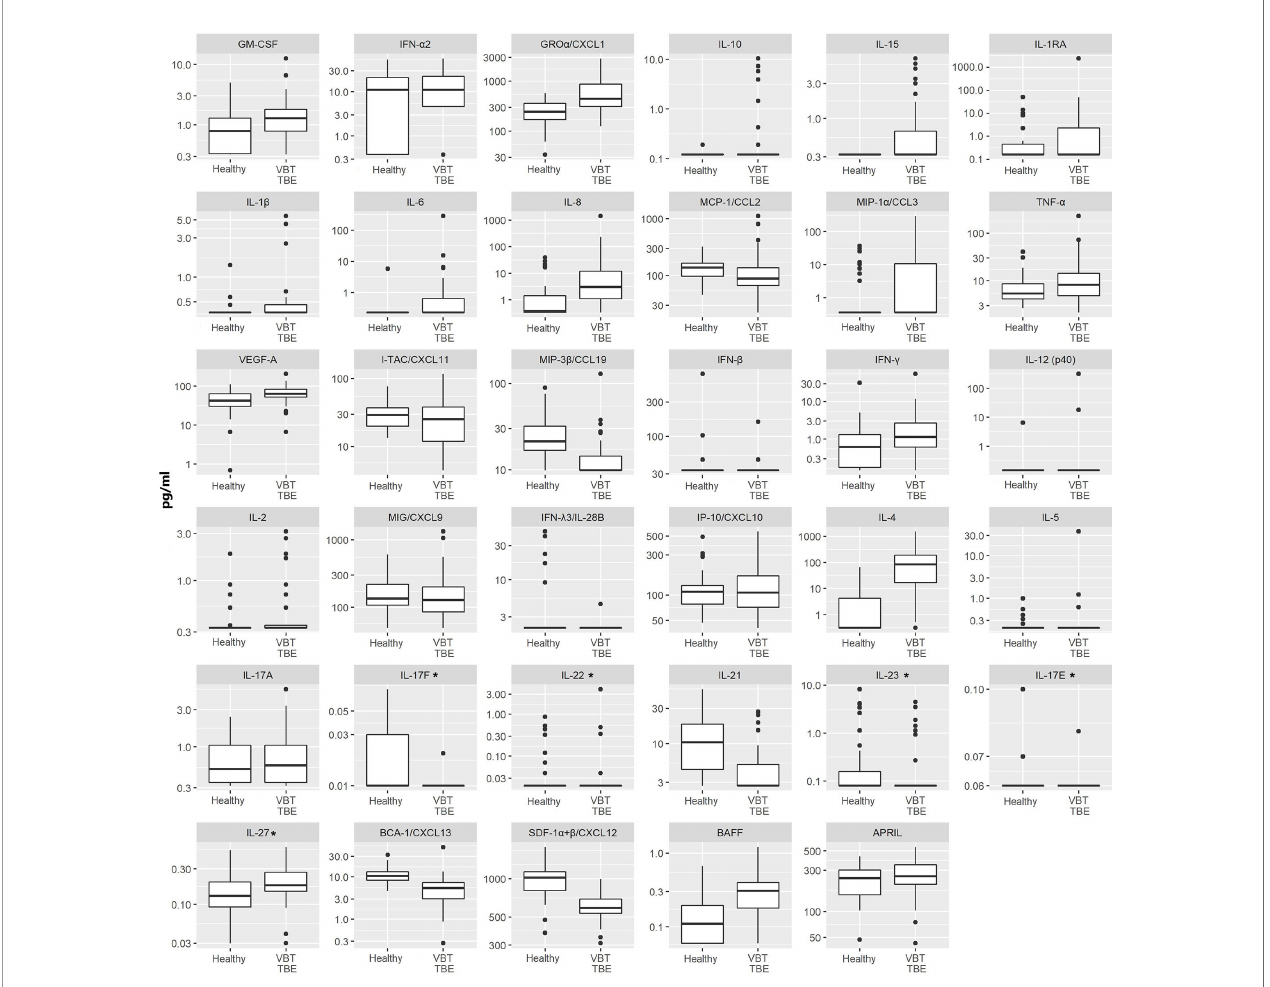
FIGURE 1 | Serum concentrations of 35 immune mediators in VBT patients (VBT; n = 41) and age and gender matched healthy individuals (Healthy; n = 42). For VBT patients, cytokine and chemokine concentrations measured in serum samples obtained at the onset of neurological symptoms are presented. Concentrations of immune mediators are in pg/ml, except those, marked with an asterisk are in ng/ml. The box and whisker plots show the median (vertical line), quartiles (box) and the whiskers, which extend to the most extreme data point which is no more than 1.5 times the interquartile range from the box; the data points outside of this range are plotted individually. Innate immune mediators: GM-CSF, IFN- a 2, GRO a /CXCL1, IL-10, IL-15, IL-1RA, IL-1 b , IL-6, IL-8, MCP-1/CCL2, MIP-1 a /CCL3, TNF- a , VEGF-A, MIP-3 b /CCL19, IFN- b ; Th1 immune mediators: IFN- g , IL-12 (p40), IL-2, MIG/CXCL9, IFN- l 3/IL-28B, IP-10/CXCL10, I-TAC/CXCL11; Th2 immune mediators: IL-4, IL-5; Th17 immune mediators: IL-17A, IL-17F, IL-22, IL-21, IL-23, IL-17E, IL-27; B cell immune mediators: BCA-1/CXCL13, SDF-1 a + b /CXCL12, BAFF,